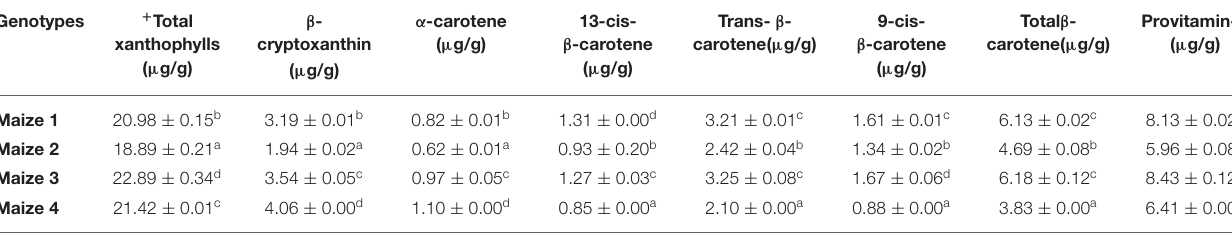
TABLE 1 | Carotenoid profile of maize grains before processing [dry weight (DW) basis].